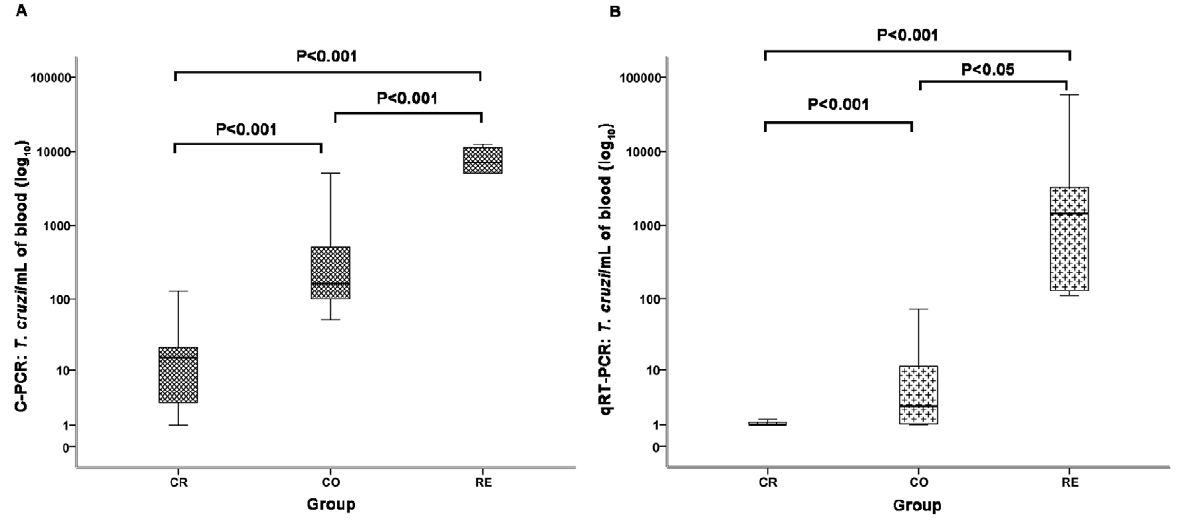
Figure 2. C-PCR and qRT-PCR in the blood of patients’ groups (CR, CO and RE). A) Number of T. cruzi /mL (log 10 ) in blood by C-PCR. CR ( n =17); CO ( n =16) and RE ( n =5). The line represents the median. Comparative analysis among the groups showed a statistically significant difference ( P , 0.001) by Kruskal–Wallis test. Comparing the groups, a statistically significant difference was observed between CR 6 CO, P , 0.001; CR 6 RE, P , 0.001; and CO 6 RE, P . 0.05) (Dunn s Multiple Comparison test). B) Number of T. cruzi /mL (log 10 ) in blood by qRT-PCR. CR ( n =57); CO ( n =29) and RE ( n =5). Comparison of the qRT-PCR results observed in the three groups of patients with Chagas disease. The results revealed a statistically significant difference ( P , 0.001) by Kruskal–Wallis test, and comparison between the groups showed statistically significant differences between CR 6 CO ( P , 0.001), CR 6 RE ( P , 0.001), and CO 6 RE, ( P , 0.05) (Dunn’s Multiple Comparison test).